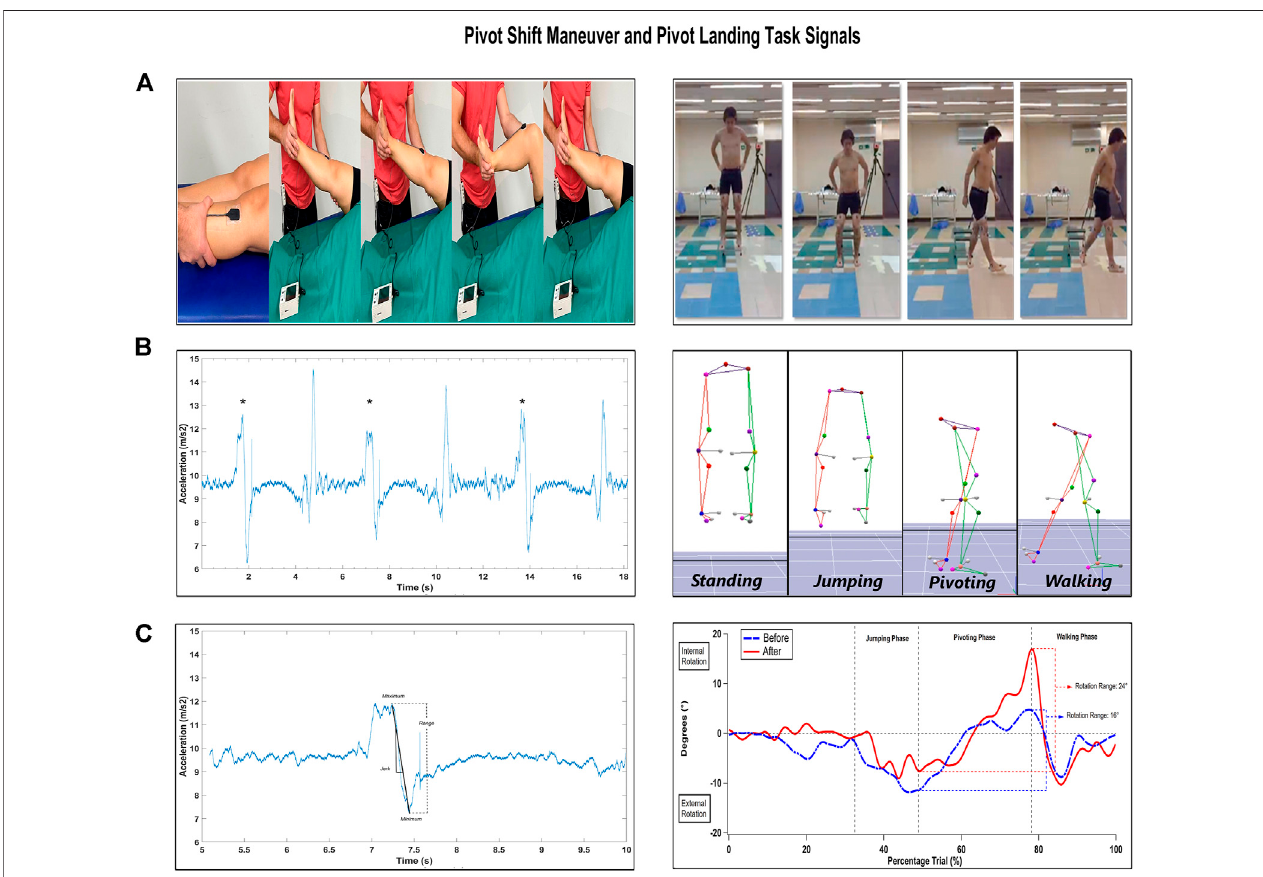
FIGURE 1 | Knee stability measurement: the pivot shift maneuver (left column) and pivot landing task (right column). (A) the sequences of the biomechanical assessments. (B) the acceleration modulus time series and the reconstructed tridimensional kinematic model. (C) the assessment outputs (acceleration range and jerk, and internal rotation range). The pivot landing task shows the standing phase, which consists of the participant standing and waiting for the order to descend. The jumpingphaseisthetaskwhentheparticipantexperiencespush-off, fl ight,andlanding.Thepivotingphaseisthetaskwhenthesubjectlandsandturnstowardthe lateral side. In conclusion, the walking phase is the moment when the participant walks in a horizontal straight line.